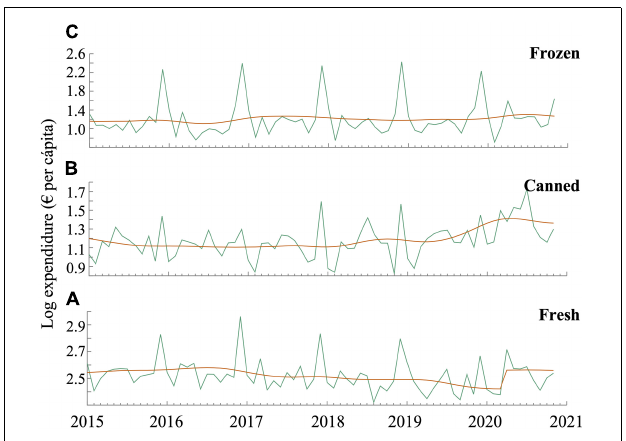
FIGURE 6 | Expenditure (€ per capita in log) on (A) fresh, (B) canned, and (C) frozen products (includes fish, mollusks and crustaceans) in Galicia. Monthly evolution of expenditure (green) and trend (orange) were